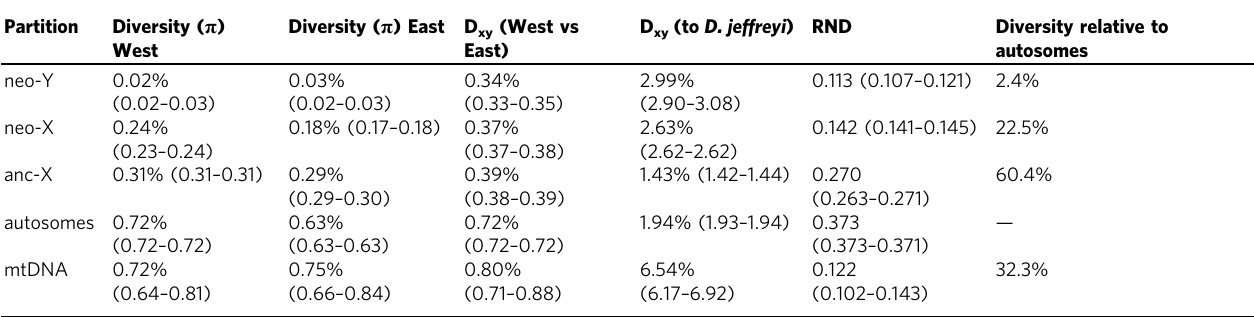
Table 2 Genetic diversity and divergence by genomic